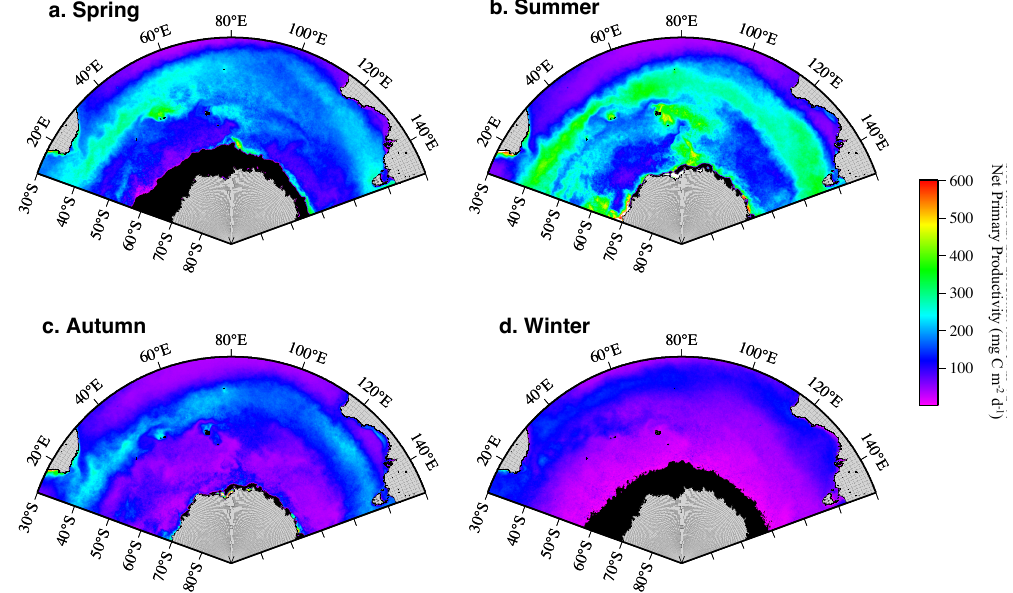
Fig. 2. Seasonal mean values of net primary productivity (mg C m − 2 d − 1 ) in the Indian sector of the Southern Ocean from 1997 to 2007 dur- ing (a) austral spring (September–November), (b) summer (December–February), (c) autumn (March–May) and (d) winter (June–August). Areas in black represent no satellite data due to cloudiness or sea ice cover.